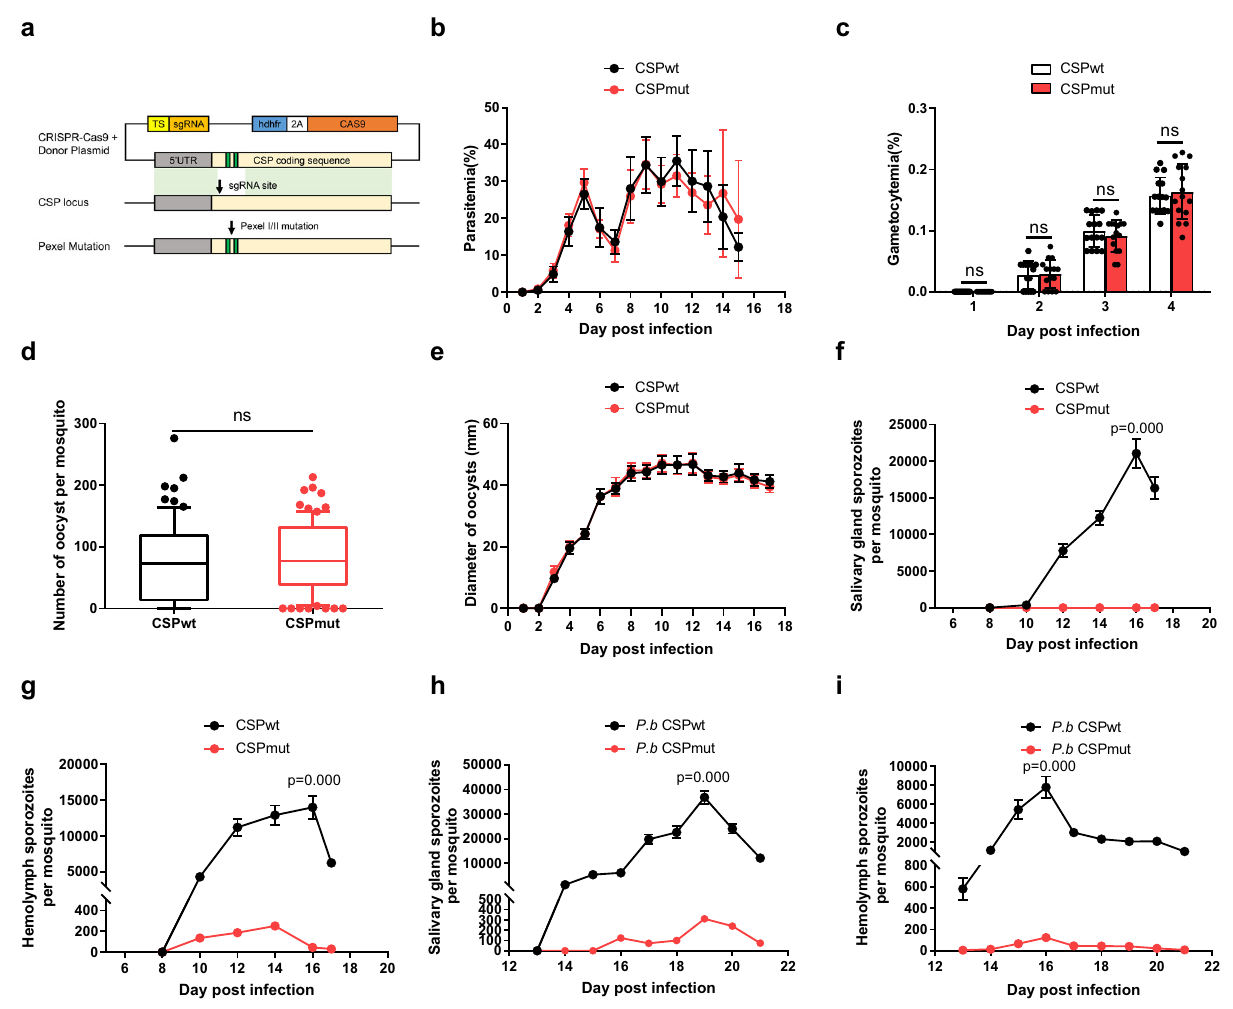
Fig. 1 Release of sporozoites from CSP mut oocyst in mosquitoes is greatly impaired. a Schematic representing the construction of the recombinant Plasmodium yoelii CSP mut parasite using CRISPR-Cas9. The amino acids of pexel I (RNLNE) and pexel II (RLLGD) in wild-type CSP were mutated into ANANA and ALAGA, respectively. Both the parasitemia ( b ) and gametocytemia ( c ) of mice ( n = 15) infected with the CSP wt or CSP mut parasites were compared at the indicated time points. The average number of oocysts ( d ) in mosquitoes ( n = 81) at day 7, and the average diameter of oocysts ( e ) under ×400 fi eld in mosquitoes ( n = 40) at the indicated time points after feeding on CSP wt or CSP mut -infected mice. The average number of salivary gland sporozoites ( f ) in mosquitoes ( n = 90), and hemolymph sporozoites ( g ) in mosquitoes ( n = 60) infected with P. yoelii CSP wt or CSP mut parasites at the indicated time points were recorded. The average number of salivary gland sporozoites ( h ) in mosquitoes ( n = 90), and hemolymph sporozoites ( i ) in mosquitoes ( n = 60) infected with P. berghei CSP wt or CSP mut parasites at the indicated time points. For box-plot diagram ( d ): middle line represents median; boxes extend from the 25th to 75th percentiles. The whiskers mark the 10th and 90th percentiles. c , d A two-sided Student ’ s t -test was used for the statistical analysis. f – i A two-sided Mann – Whitney U test was used for the statistical analysis. The data were presented as the means ± SD; ns, no signi fi cance; p -values were shown. The data were combined based on three independent experiments ( b – i ). Source data are provided as a Source Data fi